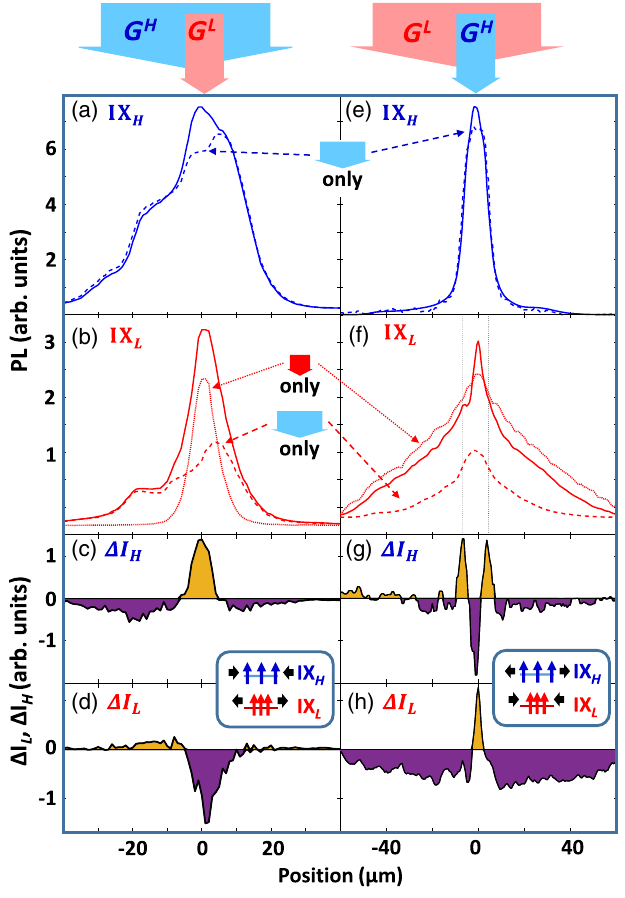
FIG. 4. (a),(b) and (e),(f): Spatially resolved PL intensity of the cross-sectional profiles recorded using the configurations of laser beams sketched on top of each column. The left (right) panels are recorded on sample A ( B ) using beam widths of 20 (6.5) and 60 μ m ( 5 . 5 μ m) for G G L and H , respectively. (c),(g) and (d),(h): Interaction-induced changes of the IX H ( Δ I H ) and IX L ( Δ I L ) photoluminescence determined from the above PL cross sections according to Eq. (2). The insets depict the expected forces exerted on the two